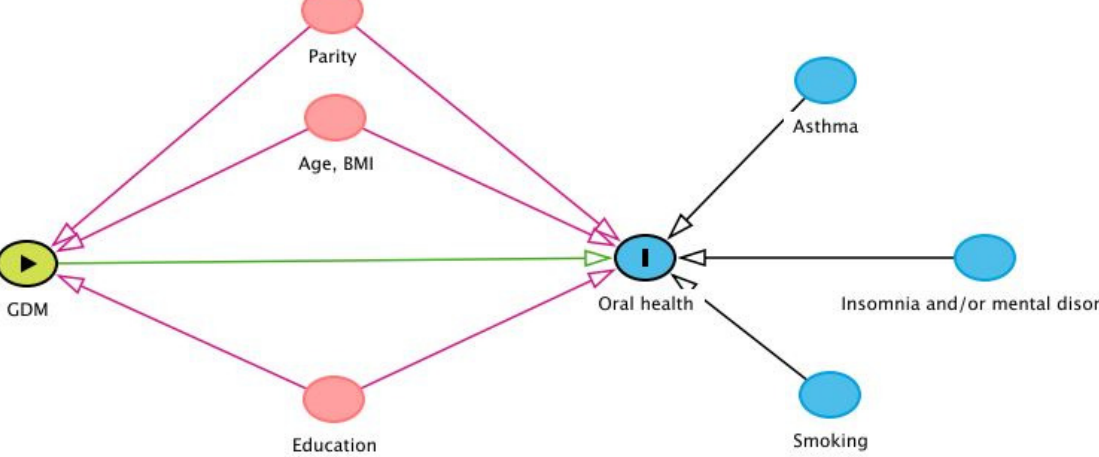
Figure 1. Directed acyclic graph showing paths between gestational diabetes and oral health. GDM, gestational diabetes mellitus; BMI, body mass index. The green oval represents exposure, the blue (I) oval is an outcome, the pink ovals are the precursors of exposure and the outcome (confounders), the clear blue ovals are the ancestors of the outcome (potential confounders), the green arrow demonstrates the hypothetical causal path, and the pink arrows demonstrate biasing paths.